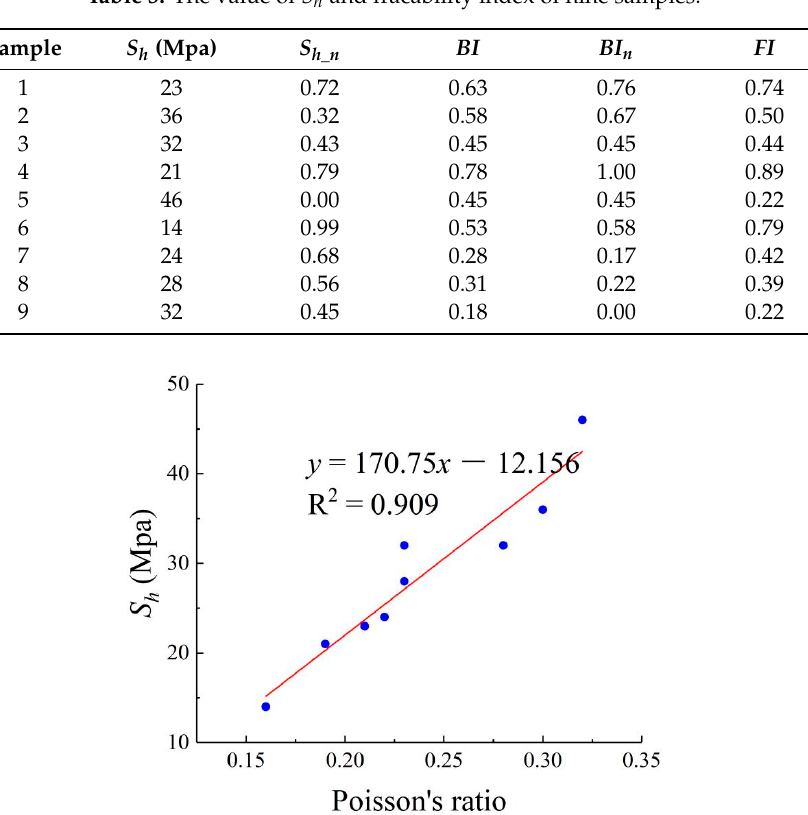
Table 3. The value of S h and fracability index of nine samples.